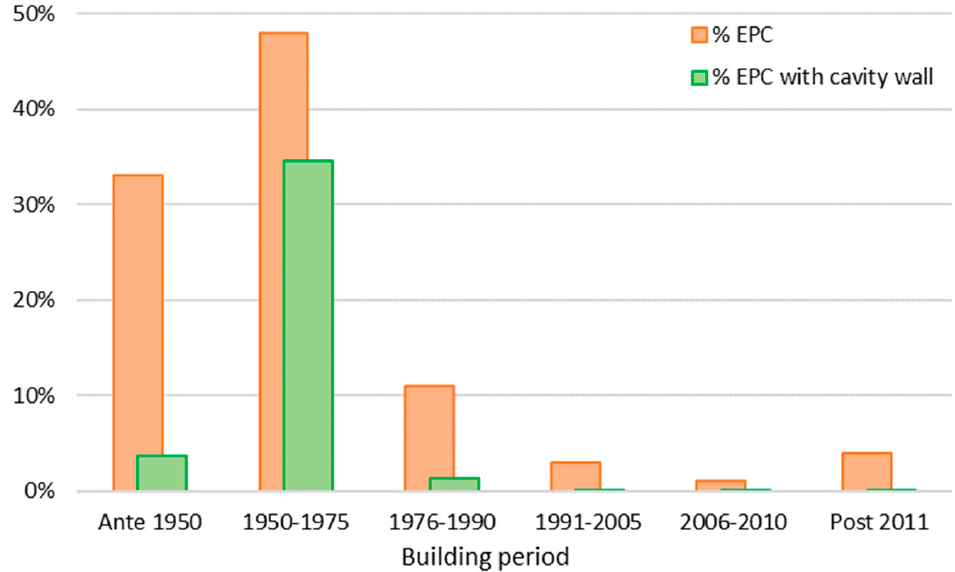
Figure 11. Cavity thickness incidence. Note: For cavity > 300 mm, the thickness incidence is 0%.